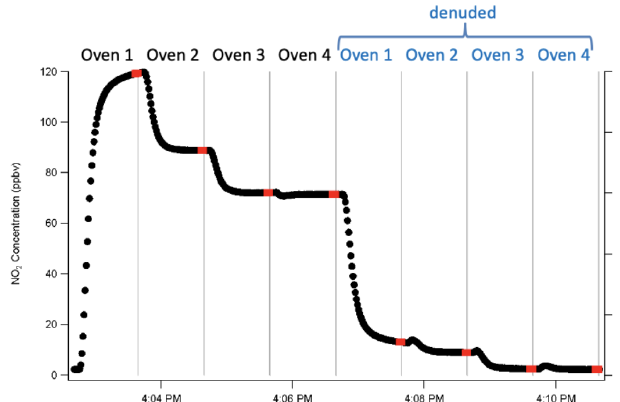
Figure 2. One full cycle through total and then denuded channels. Points indicated in red are those averaged to obtain the concentra- tions that are subsequently subtracted. Vertical lines indicate times when the valve switched between